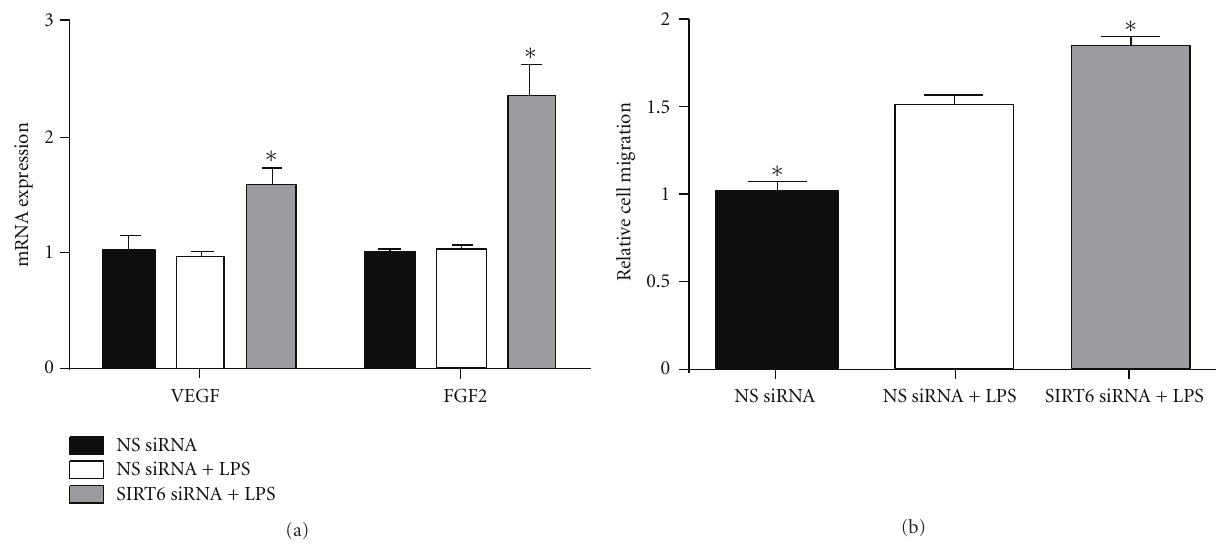
Figure 7: E ff ect of SIRT6 siRNA on HUVEC angiogenic proteins and cell migration. HUVECs were transfected with 50 nM SIRT6 or NS siRNA for 72h followed by 10 μ g/mL LPS for 24h ( n = 4). (a) The gene expression of the proangiogenic proteins VEGF and FGF-2 was quantified by qRT-PCR. Each bar represents the mean ± SEM. ∗ P < 0 . 05 versus NS siRNA + LPS. (b) Transfected HUVECs were put into transwell inserts coated on the underside with 0.1% gelatin. The total number of migrating cells were counted after 5 h at 37 ◦ C. Fold change was calculated relative to NS siRNA transfected cells. Each bar represents the mean ± SEM. ∗ P < 0 . 05 versus NS siRNA + LPS.